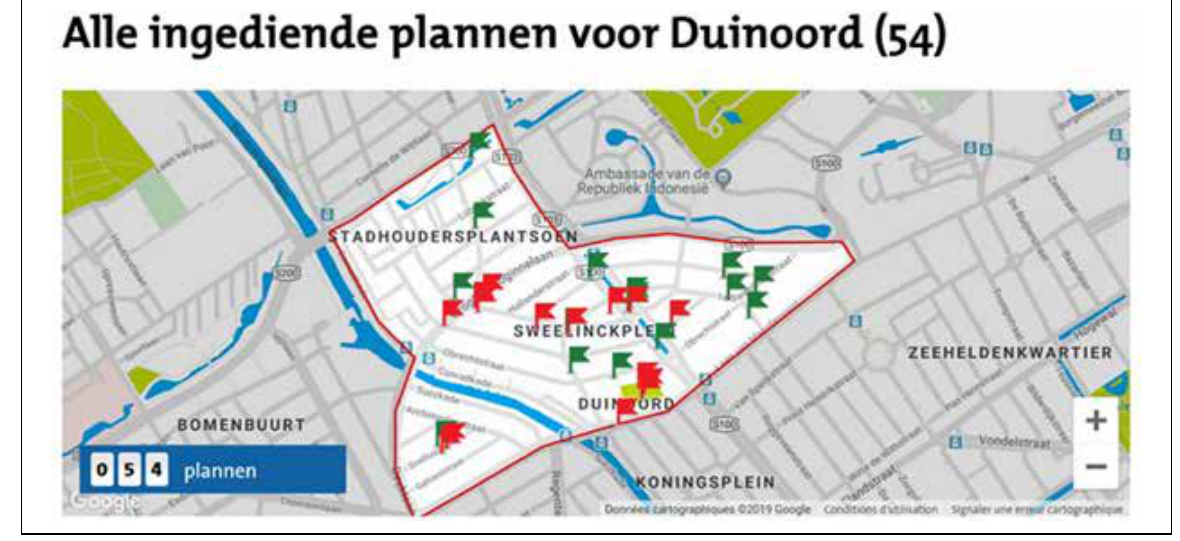
Figure 2: Distribution of proposals across the neighborhood. Note/source: Red/green flags: proposal not selected/selected for the final voting stage. Retrieved from https://www.